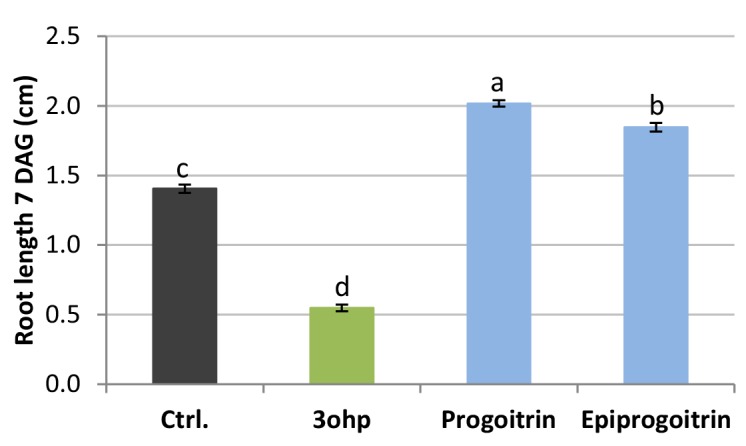
Root lengths of 7 DAG Col-0 WT grown on MS media supplemented with 50 µM of the indicated GSL.Progoitrin = R enantiomer of 2-hydroxybut3-enyl GSL and Epiprogoitrin is the S enantiomer. Results were obtained in two fully independent experiments and tested with ANOVA. LSmeans are shown with letters showing treatments with statistical differences following a Tukey’s post-hoc t-test. The samples sizes are 97 seedlings for control, 152 for 3OHP, 160 for progoitrin and 94 for epiprogoitrin. LSmeans and SE are plotted.